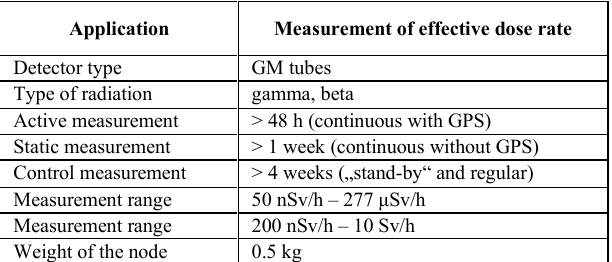
M AIN PARAMETERS OF THE RMS-001 MODULE